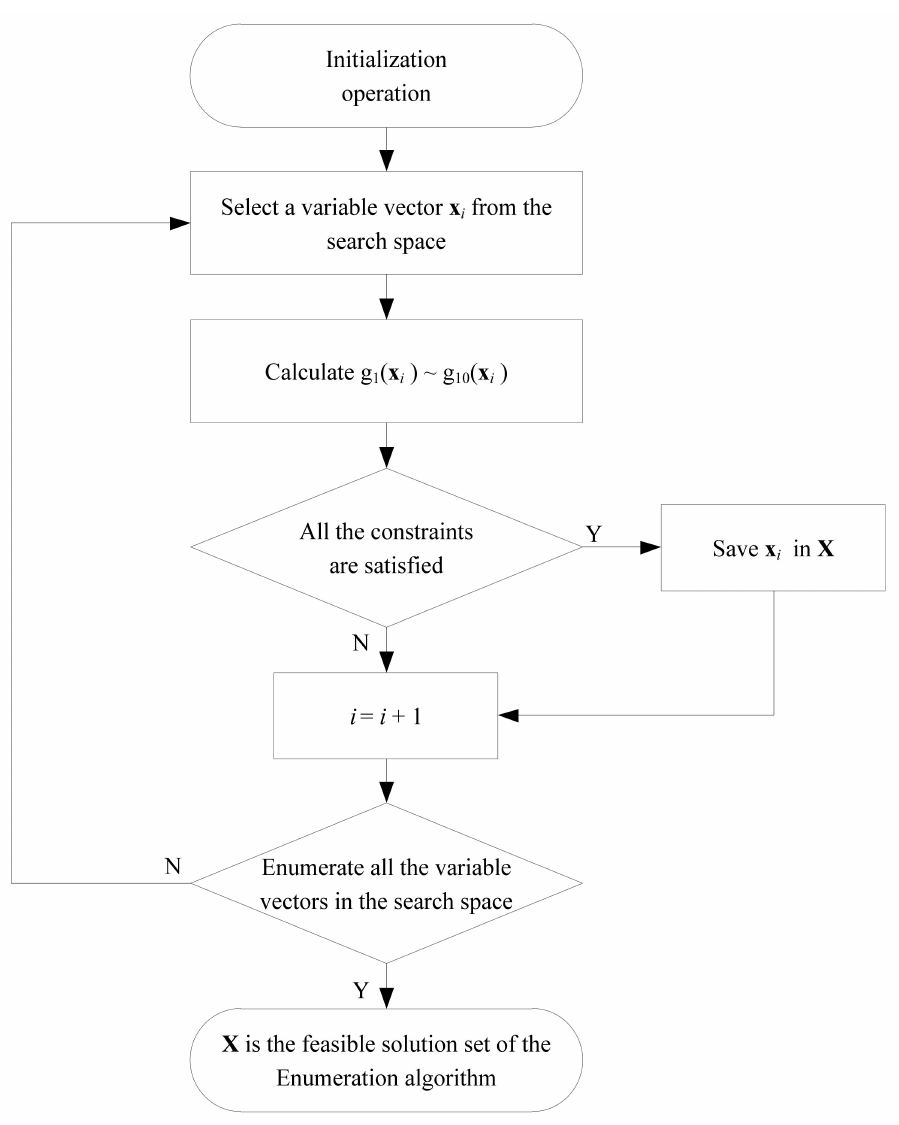
Figure 6. The flow chart of the procedures for the variable